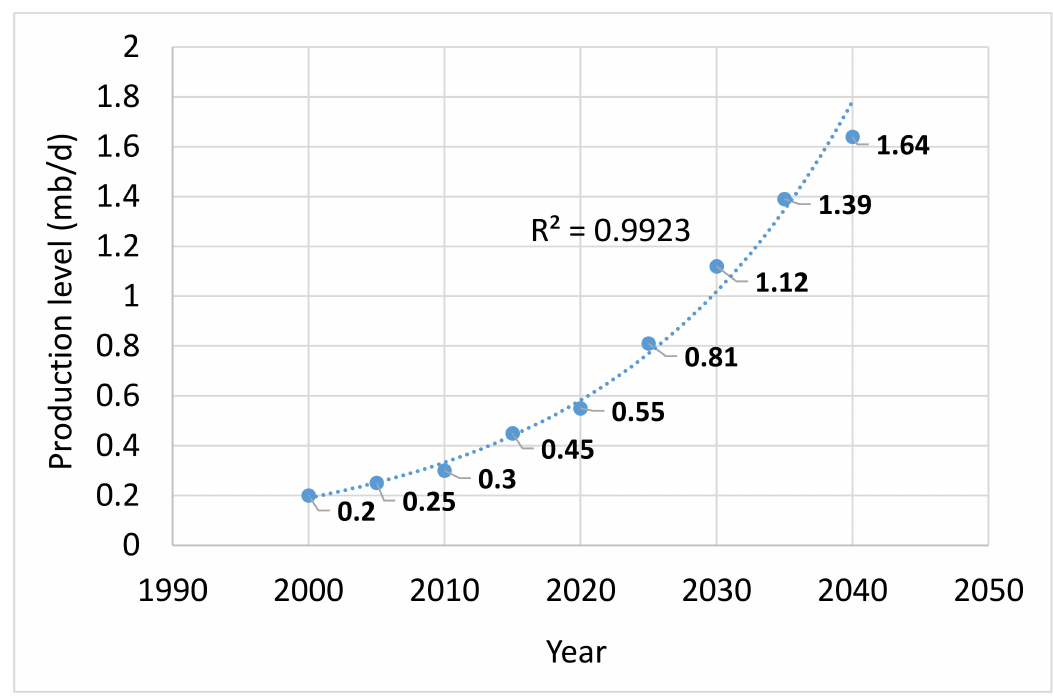
Figure 10. Growth in global enhanced oil recovery (EOR) levels, source of data: McGlade et al.